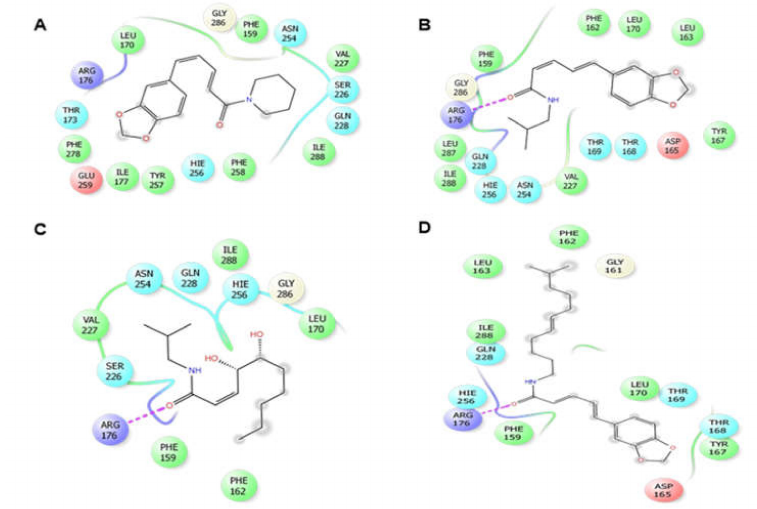
Figure 3. 2D interactions of the piperine ( A ), piperlonguminine ( B ), sylvamide ( C ), and sylvatine ( D ) with the active site of xanthine oxidoreductase (PDB: 1R4U). Colors indicate the residue (or species)